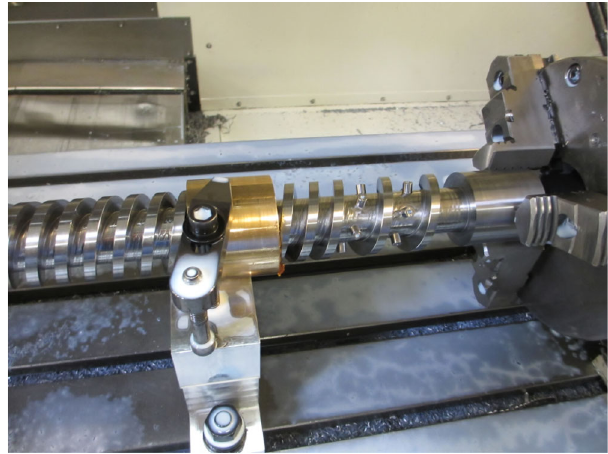
FIG. 7. Computer model of the integrated turn around concept with the turn-around sleeves and extensions in an exploded view on the left side and installed for winding on the right side.